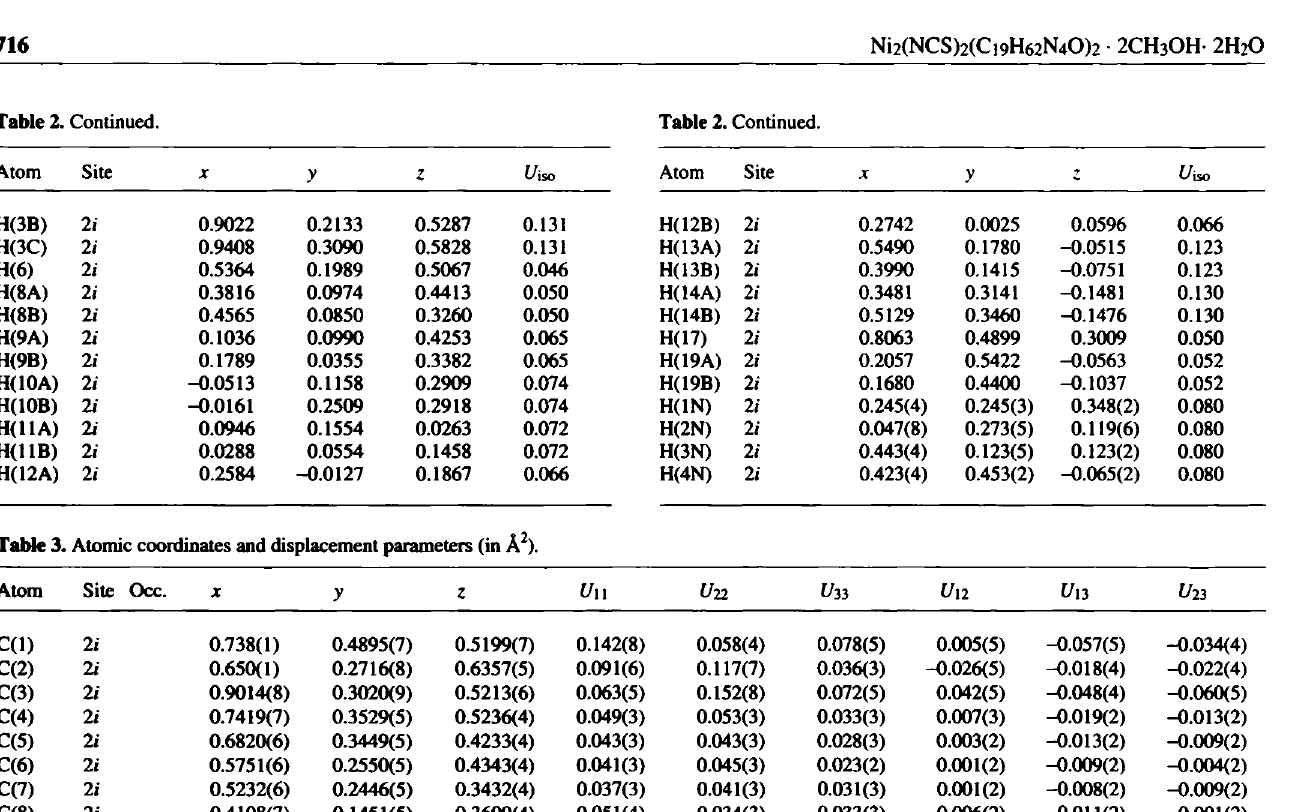
Table 3. Atomic coordinates and displacement parameters (in Â 2